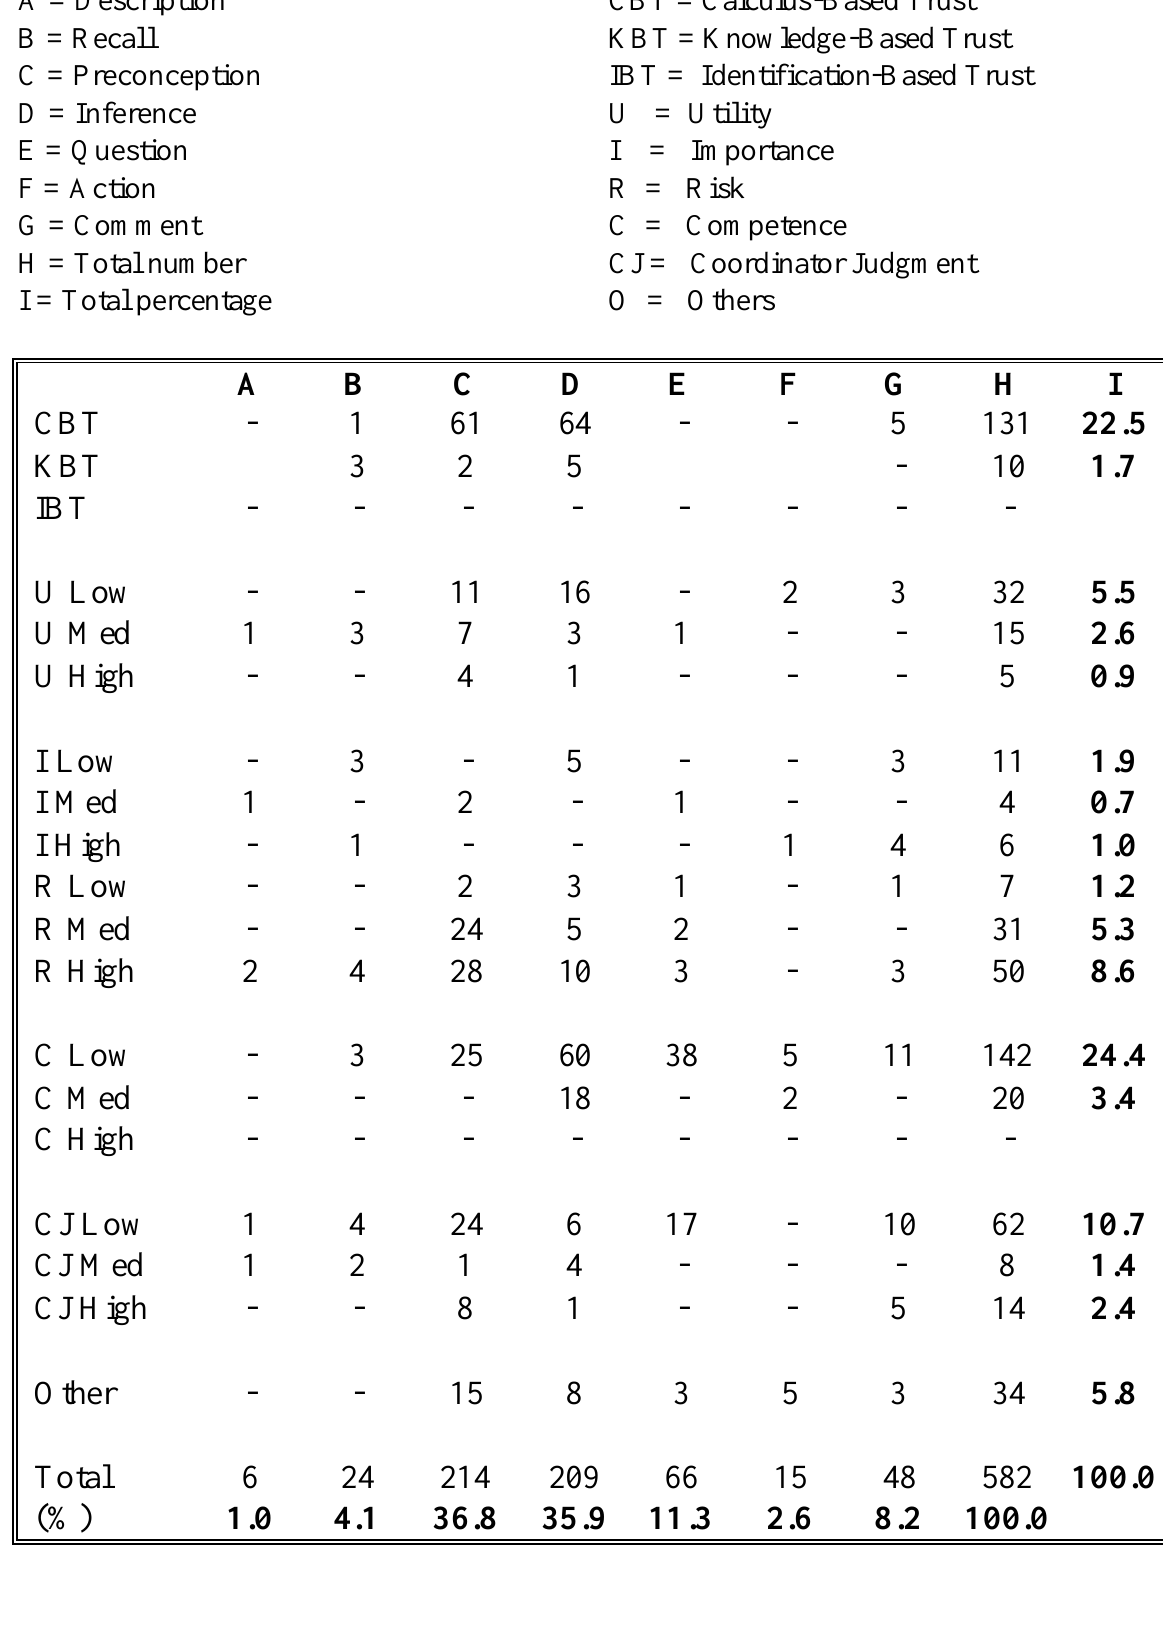
Consolidated verbal protocol frequency analysis